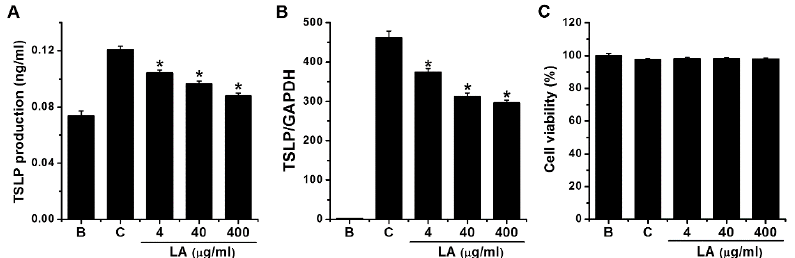
Figure 2. Effects of LA on the production and mRNA expression of TSLP in HMC-1 cells. ( A ) HMC-1 cells (3 × 10 5 ) were pretreated with LA at concentrations of 4 to 400 µ g/mL for 1 h, and then stimulated by PMA plus A23187 for 7 h. The TSLP levels in the supernatant were assessed using ELISA method. ( B ) HMC-1 cells (1 × 10 6 ) were stimulated by PMA plus A23187 for 5 h. The levels of TSLP mRNA expression were measured using qPCR method. ( C ) HMC-1 cells (3 × 10 5 ) were pretreated with LA at the doses of 4 to 400 µ g/mL for 1 h, and then stimulated with PMA plus A23187 for 7 h. Cell viability was